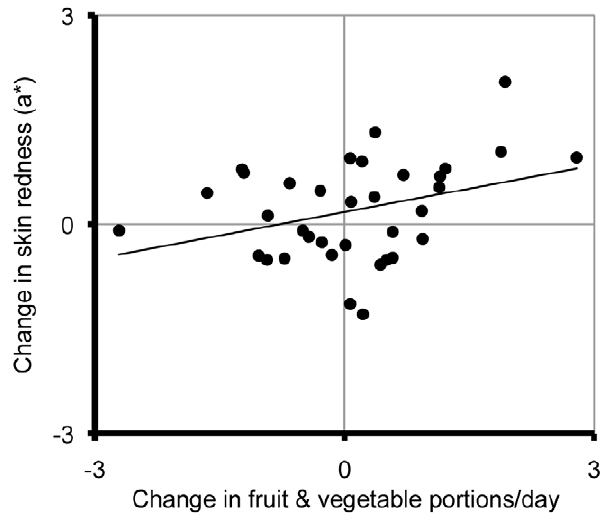
Figure 3. The relationship between six-week changes in fruit and vegetable intake and average skin yellowness (b*).